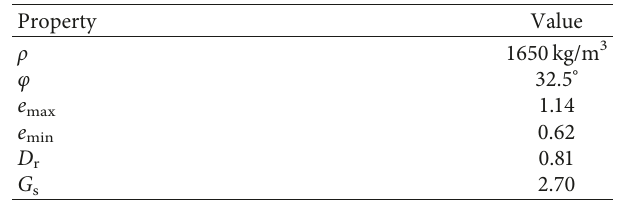
Figure 2: Plan view of the pile groups. (a) 3 b pile spacing. (b) 6 b pile spacing. Table 1: Physical properties of